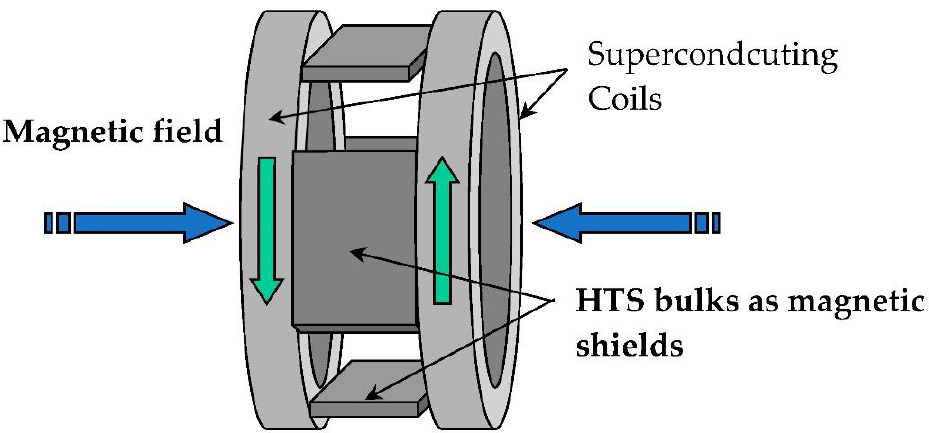
Figure 2. Inductor of the motor with HTS bulk magnetic flux concentration.